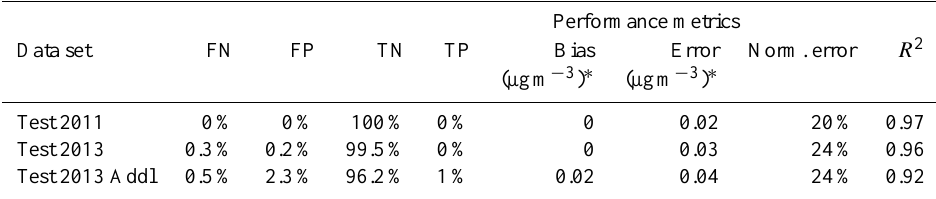
Table 5. FT-IR EC, anticipation of the prediction error per sample. Percentage of ambient samples falling in the FN (false negative), FP (false positive), TN (true negative), and TP (true positive) sectors. Performance metrics of the models that exclude predictions of samples that fall in the FP and TP sectors.